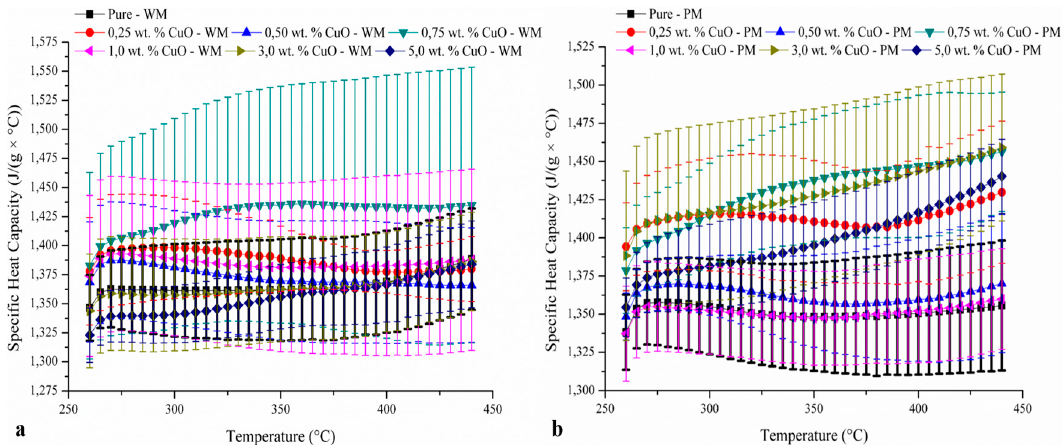
Figure 5. Specific heat capacity of the different ratios of salt tested using both the wet mixing ( a ) and the powder mixing ( b ) methods.